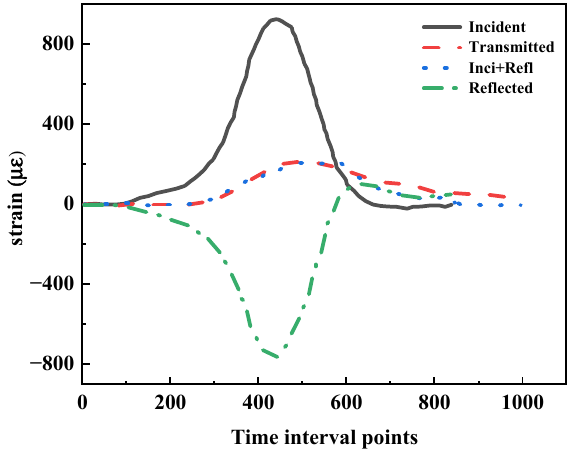
Figure 10. Typical incident, reflected and transmitted pulses in the stress balance test.